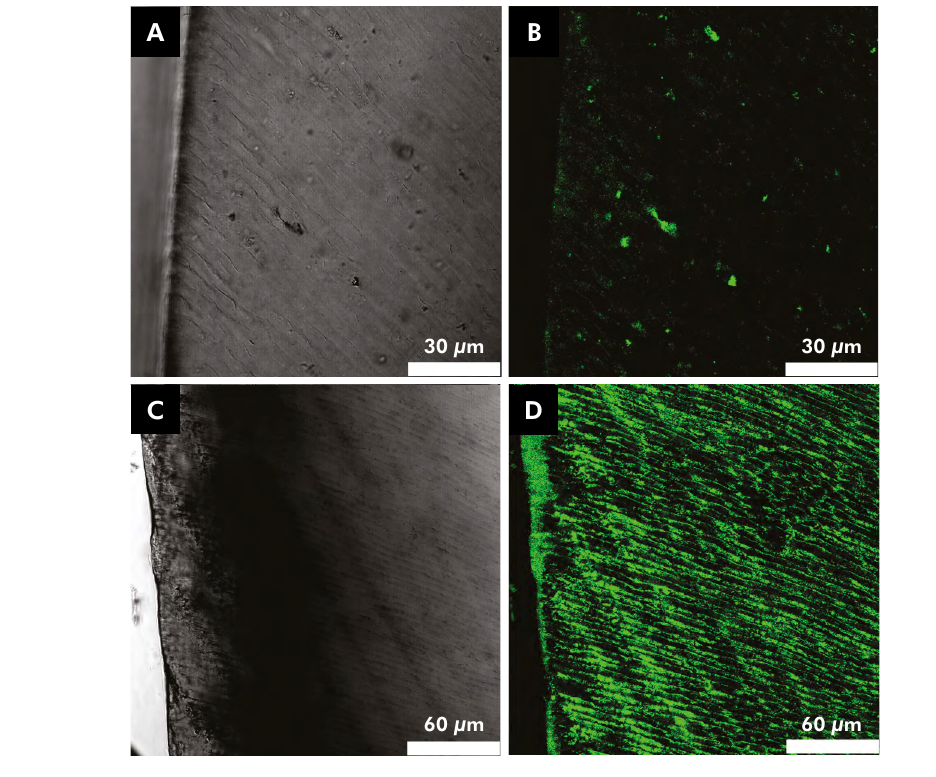
Figure 1. Representative images obtained with CLSM in combined mode of transmission and fluorescence. A. Positive control did not show any structural changes in the enamel (transmission mode). B.- There was no evidence of NaFl in the tissue (fluorescence mode). C. Negative control; porous structures of the lesion body, in black, owing to the scattering of light between the crystals (transmission mode). D. Negative control; green porous structures caused by NaFl, confirming the formation of artificial caries lesions in the enamel (fluorescence